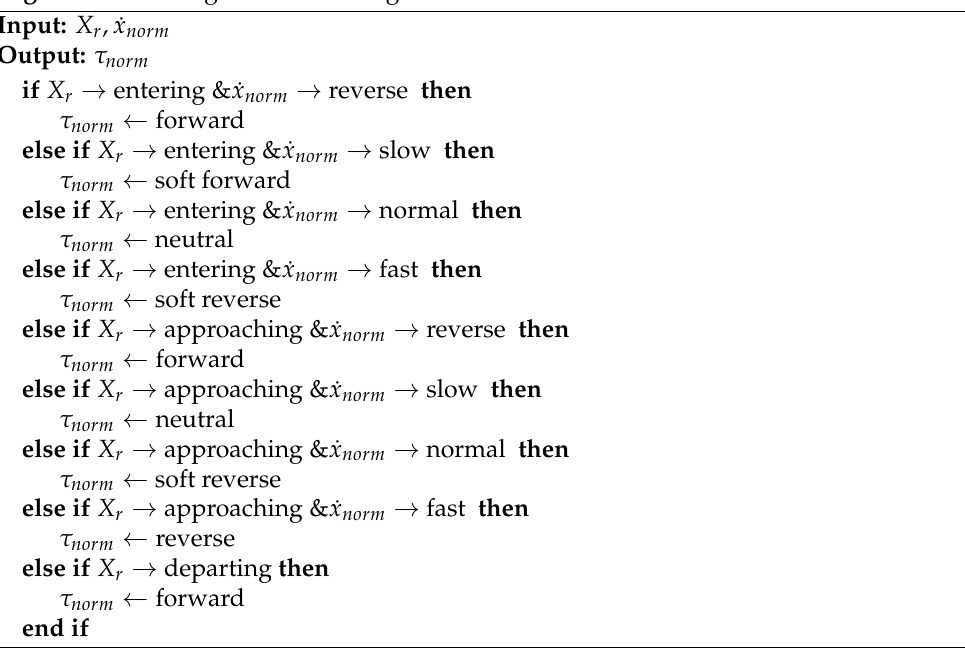
Algorithm 4 Red light FIS knowledge